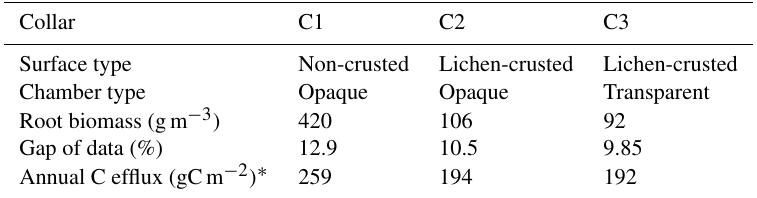
Table 1. Configuration of soil collars used in this study.